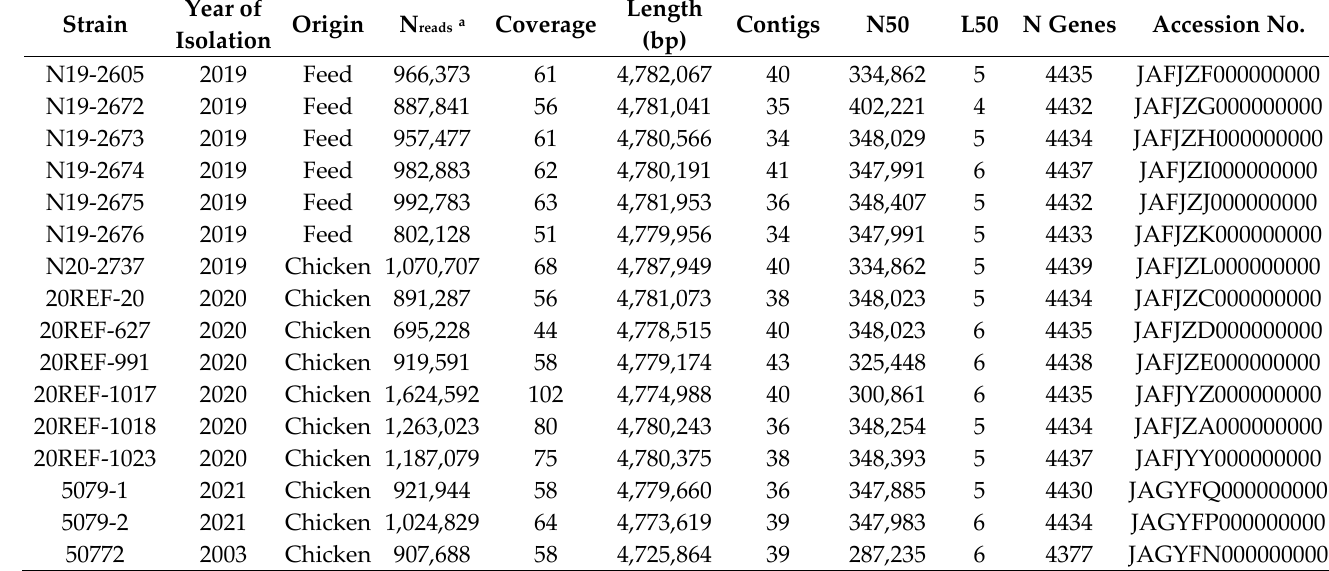
Table 2. Characteristics of the sequences of the 16 Salmonella Jerusalem isolates.